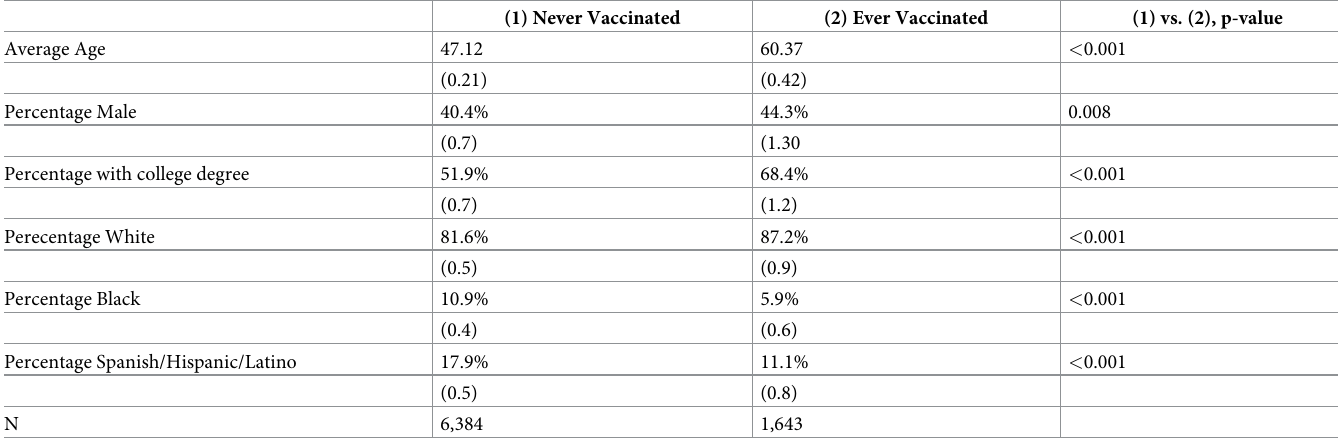
Table 1. Backround